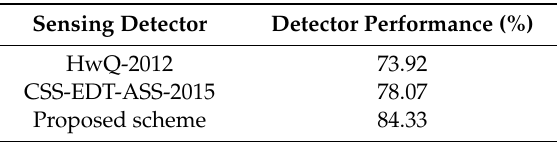
Table 5. Comparisons of cooperative detectors.